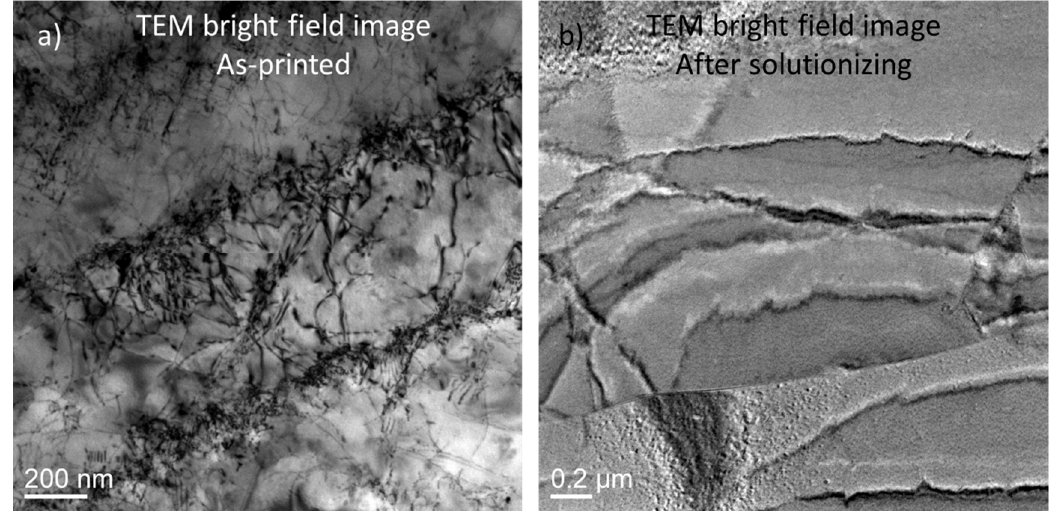
Figure 2. ( a ) Bright field TEM image of the as-printed sample. High dislocation density is clearly evident, ( b ) TEM bright field image after solutionizing